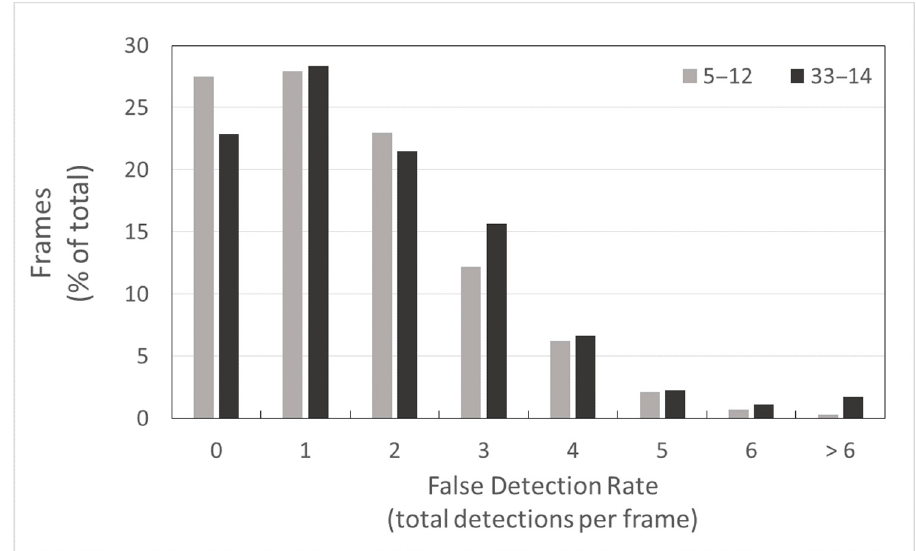
Figure 13. Classified per-frame target misdetections—Comparison between scenarios. Table 1. Direct comparison between scenarios. The table indicates the percentage of frames for which each scenario outperformed the other in terms of correct detections, including the percent- age of frames where performance was equal.